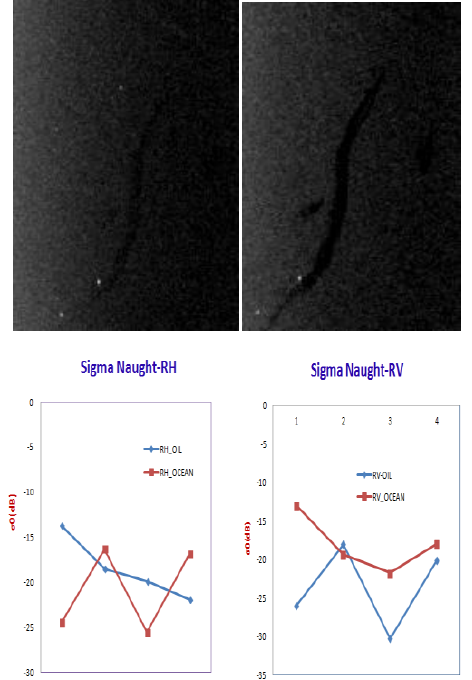
Figure 1: Sigma Naught Date of Imaging: 17-June